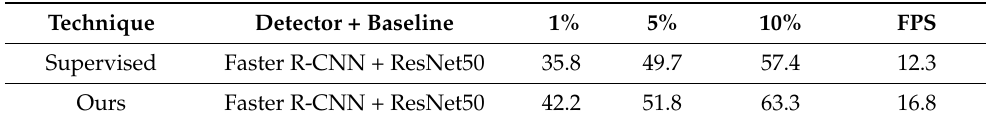
Figure 9. The results of our model with Faster R-CNN and ResNet50 that is trained on 10% of IIIT-AR-13K labeled data. Blue represents True Positives and Red represents False Positives. In this figure, ( left ) represents a couple of samples with True Positives, ( right ) depicts True Positive and False Positive. Table 9. Performance comparison in terms of mAP (0.5:0.95) between supervised and our semi- supervised model trained on 1%,5% and 10% of the IIIT-AR-13K dataset. Both the models use Faster-RCNN with ResNet 50 backbone.